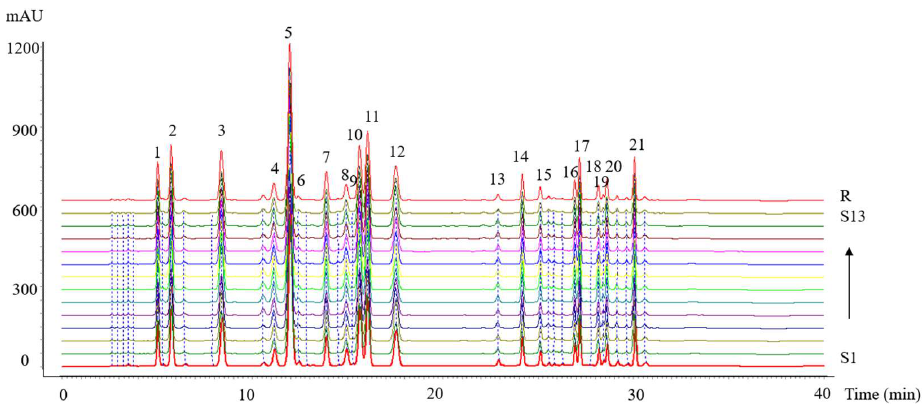
Figure 2. The HPLC fingerprints of the amino acids of 13 batches of collagen peptide samples (S1–S13) and amino acid reference standard fingerprint (R). Table 3. The RRT and RPA of the common peaks of the amino acids. Peak No.